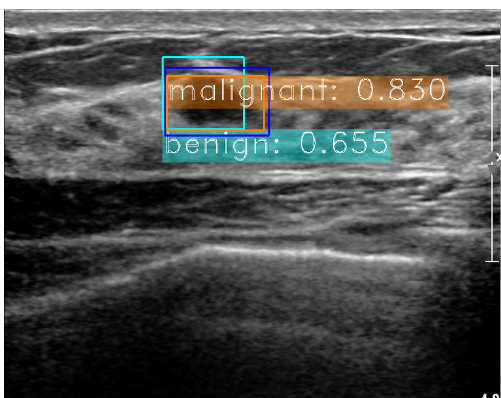
Figure 3. Example of a double prediction case in Breast ultrasound (BUS) images. The bounding box in blue represents the ground truth for a benign mass. Predicted boxes are colored in orange and cyan for malignant and benign predictions,